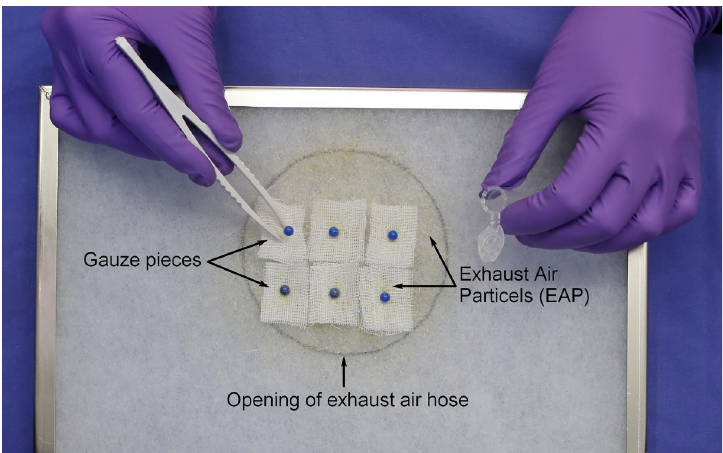
Fig 1. Schematic representation of EAP sampling. The black circle marks the position of gauze pieces attached to the prefilter directly above the opening of the exhaust-air hose in the ventilation unit. Gauze pieces were attached within this area using pins and were removed weekly with disposable